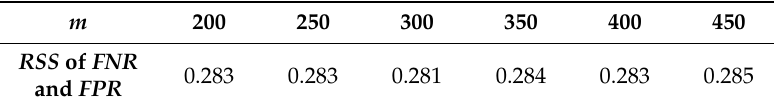
Table 1. Root sum square of false negative rate ( FNR ) and false positive rate ( FPR ) when m varied from 200 to 450 and T r = 15.